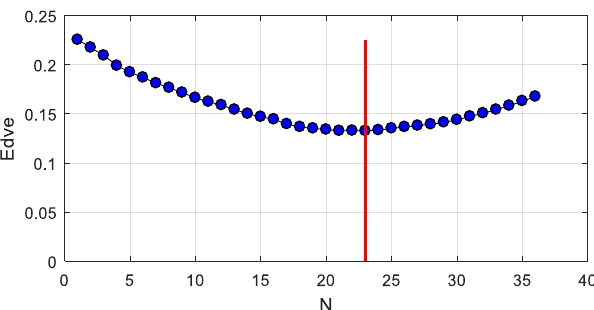
I . Figure 11. Influence of N for mean deviation of vector I lshoulder - to - lelbow lelbow-to-lshoulder